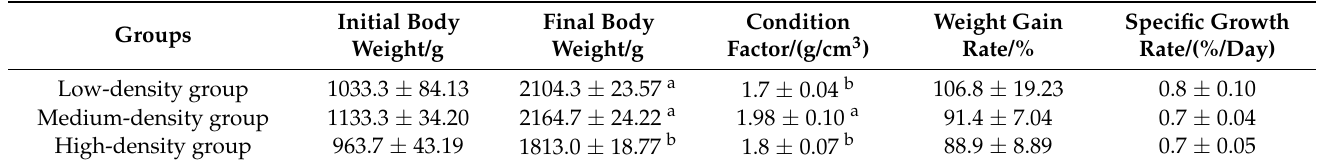
Table 1. The growth indicators of yellowtail kingfish under different densities.